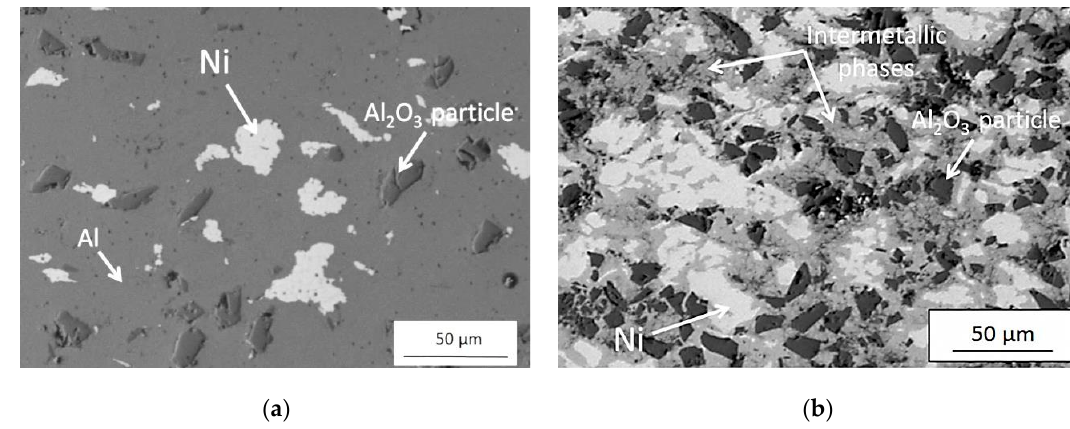
Figure 9. Micrographs (SEM, BSE) of 49% Al coating heated by resistance spot welding process with parameters No. 3 ( a ) and No. 4 ( b ).